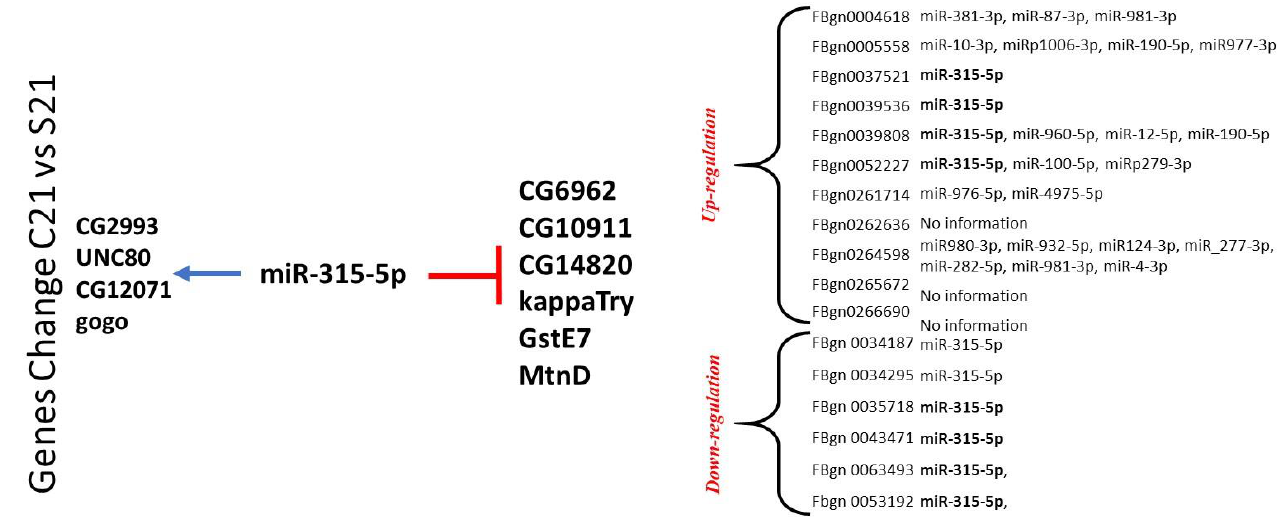
Figure 4. All of the genes analyzed had potential targeting sites by different microRNAs. The frequency of miR-315-5p in the gene list was highest and, notably, evolutionarily conserved among multiple Drosophila species unlike any other mi- croRNAs studied. The involvement in miR-315-5p suggests several potential targets.